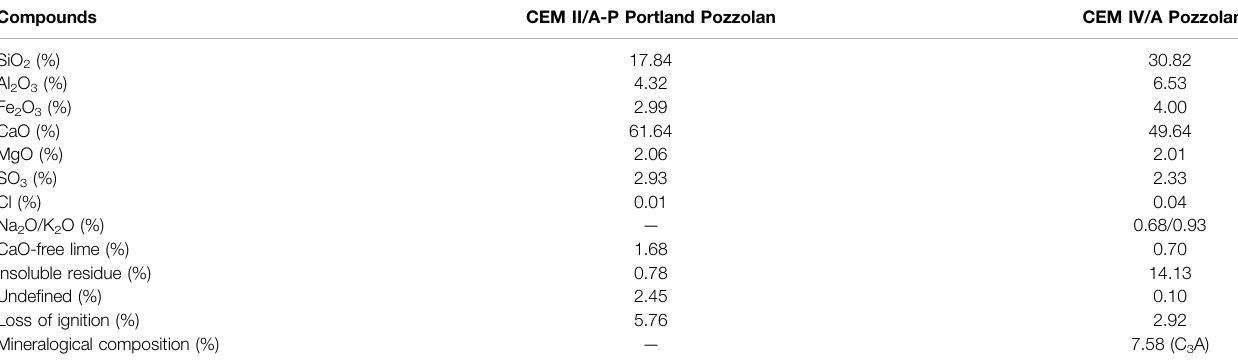
TABLE 1 | Chemical analysis of binders types used during the